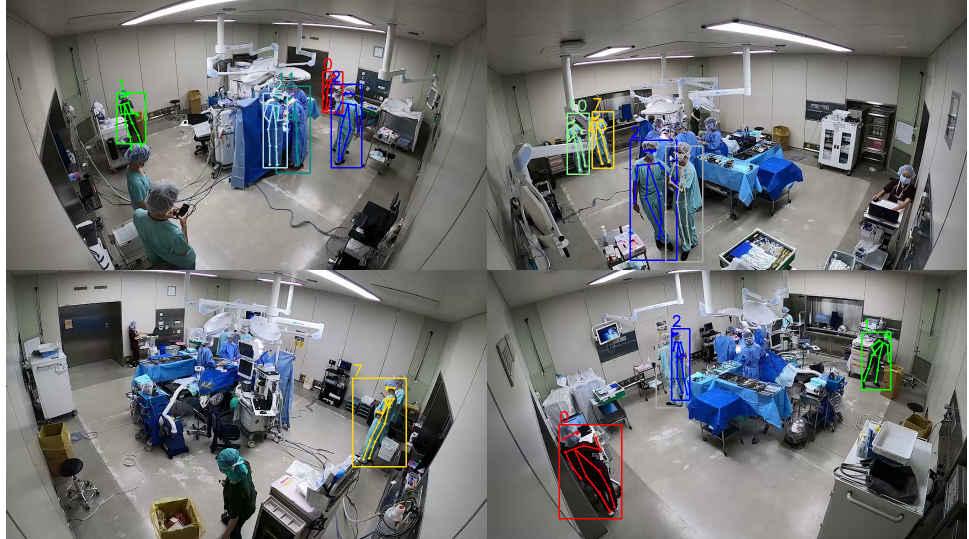
Figure 7. Pictures captured by different cameras with human